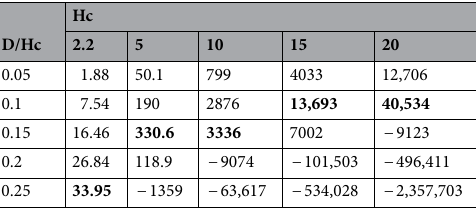
Table 3. Interaction effect of D and Hc. Significant values are in bold.